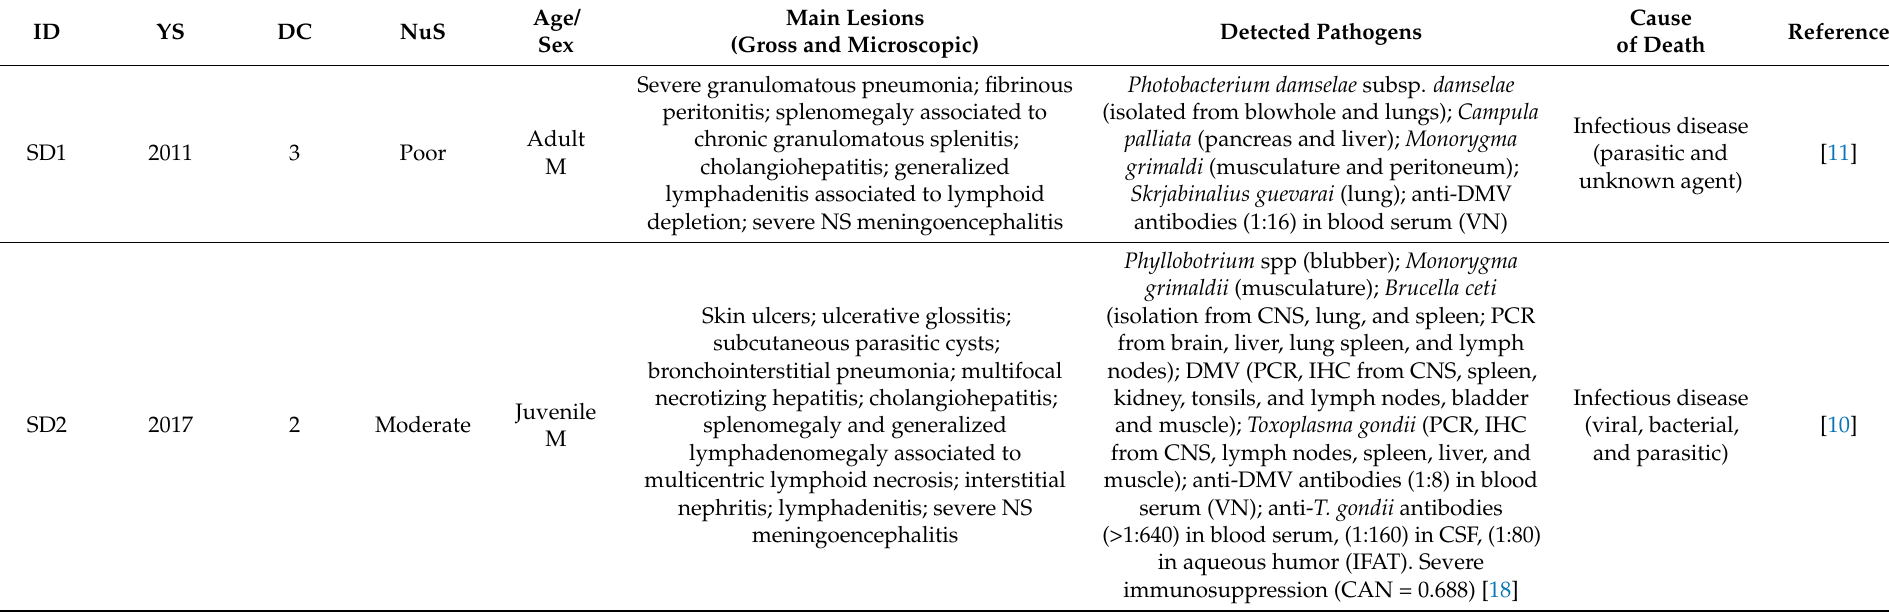
Table 1. Stranding data, body condition, most significant findings (gross and microscopic), pathogens detected, and the hypothesis of causa mortis in the two animals under